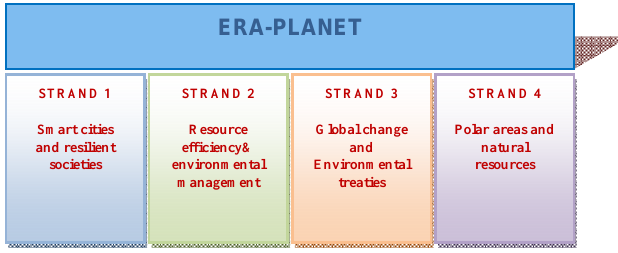
Figure 1. Strands selected for the implementation of ERA-